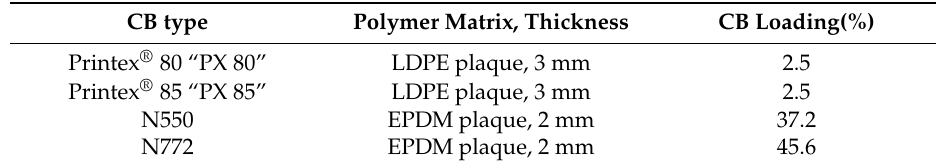
Table 1. Low density polyethylene (LDPE) and ethylene propylene diene monomer (EPDM) based carbon black (CB)-nanocomposites used as test materials.